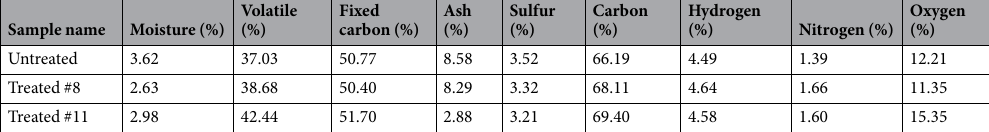
Table 1. Ultimate analysis for untreated and bioconverted coals.